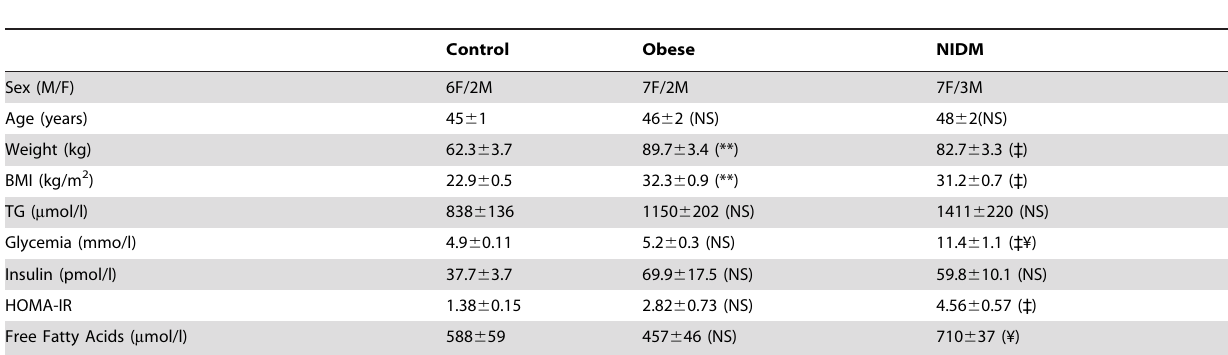
Table 1. Metabolic characteristics of lean, obese and type 2 diabetic patients (n=8–10) in fasting